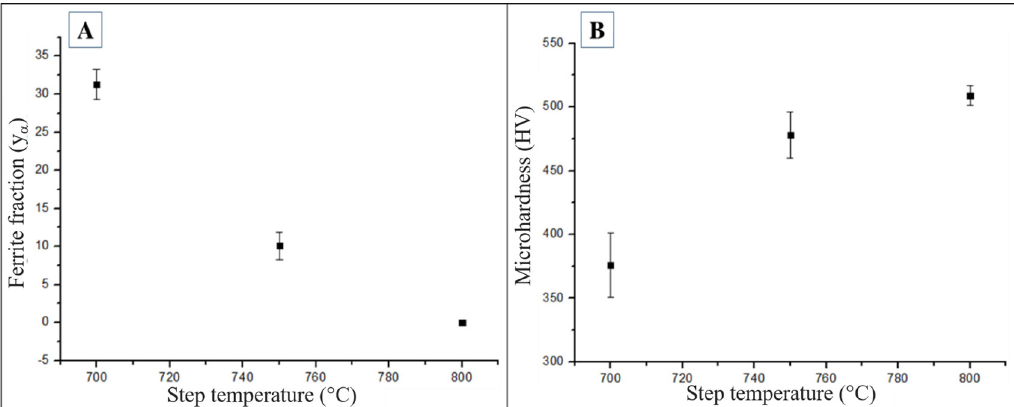
) as a function of step temperature in the quasi-equilibrium and B) vickers microhardness (HV) as a Figure 3. A) Ferrite fraction (y α function of step